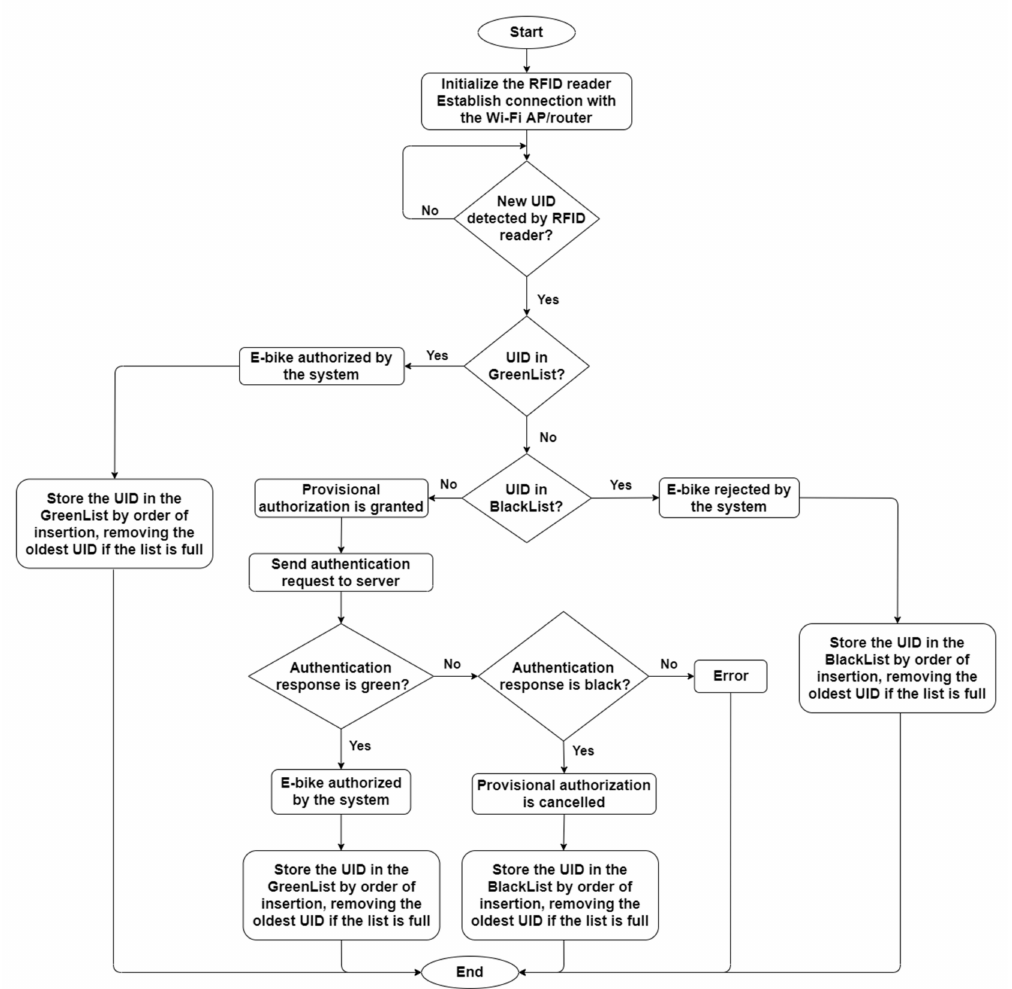
Figure 6. Flowchart of the authorization processing performed by the ESP32 boards at the